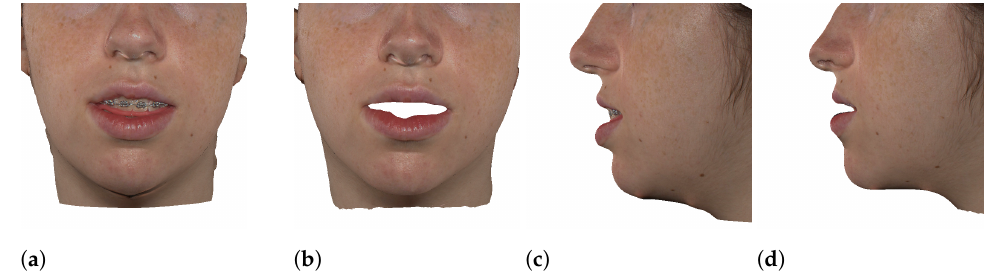
Figure 9. Preoperative 3D scan ( a , c ) and textured output ( b , d ) of patient M7, in frontal view ( a , b ) and lateral view ( c , d